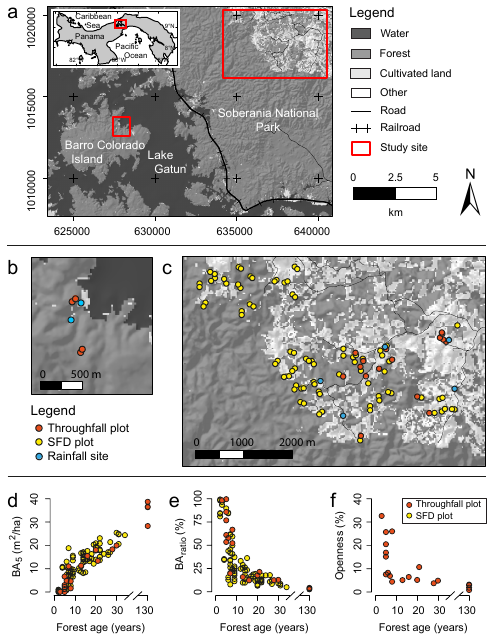
Fig. 1. Location of the study sites in central Panama (a) , detailed view at the BCI (b) and the ASP study area (c) , and relationship be- tween forest age and BA 5 (basal area) (d) , between forest age and the BA ratio (ratio of the basal area of small stems to the total basal area) (e) , and between forest age and canopy openness (f) . Note: for a description of SFD plots and throughfall plots, refer to Sects. 2.1 and 2.2.1; for an in-depth description of the forest structure vari- ables, refer to Sect.